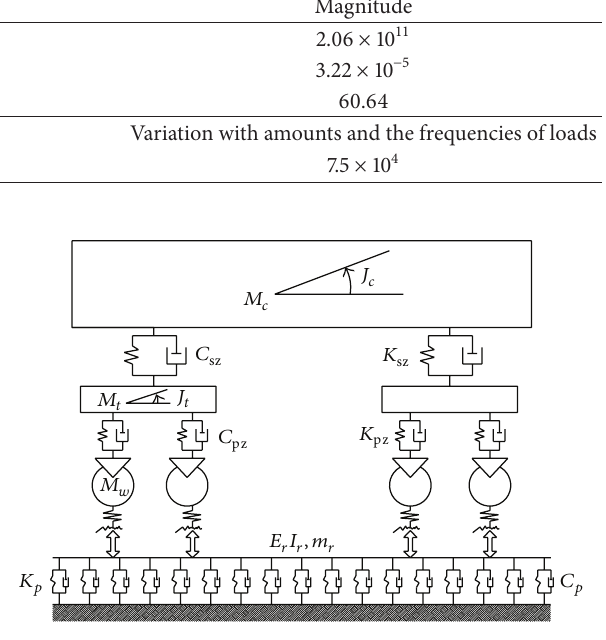
Figure 6: Vehicle-track coupled dynamic